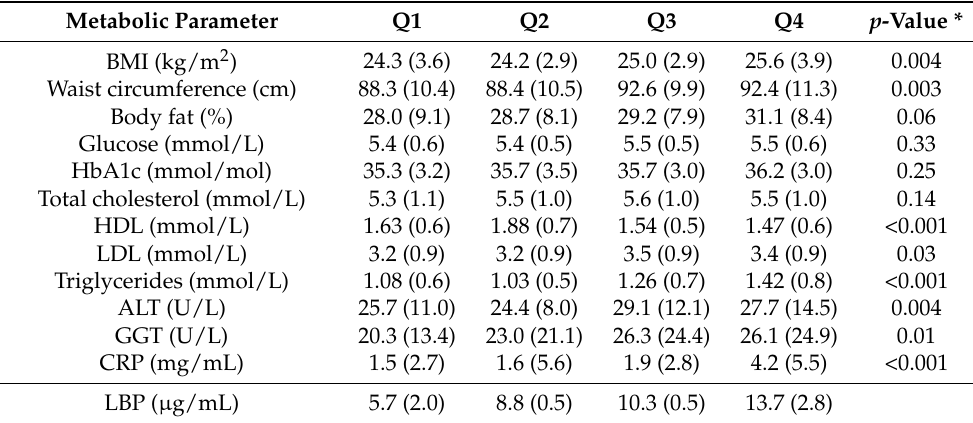
Table 6. The quartile analyses for LBP including all individuals ( n = 500).